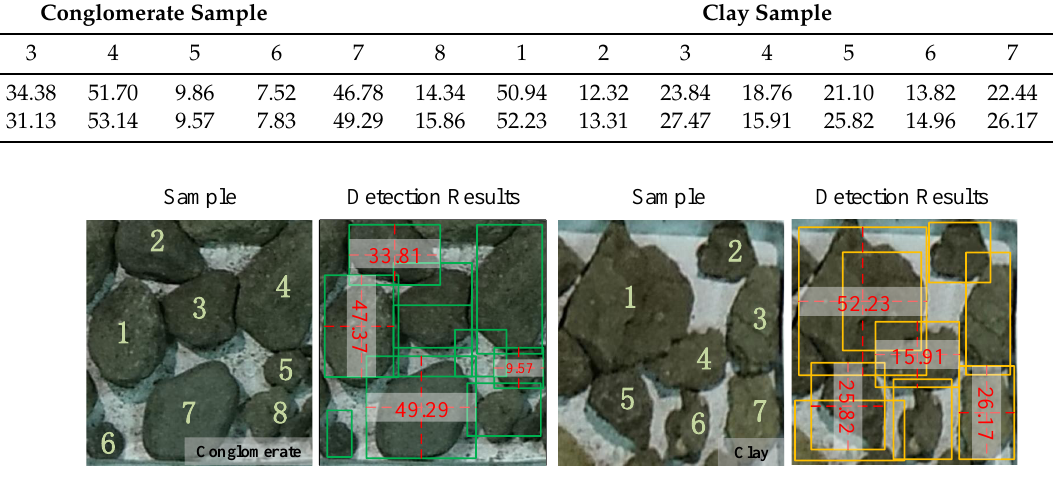
Figure 8. The illustration of sampling materials and their detection and prediction